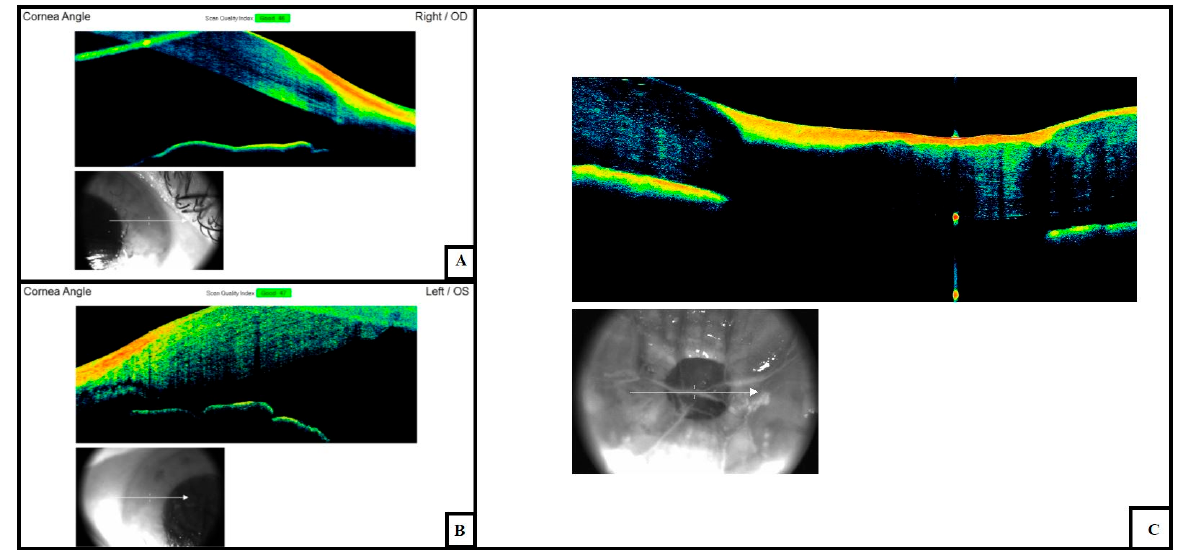
Figure 4. Changes in the anterior chamber amplitude at ( A ) early (6th hour), ( B ) intermediate (24th–36th hour) and ( C ) advanced (72nd hour) postmortem intervals. This phenomenon can be explained by changes in the corneal thickness and variations in the intraocular tone due to the loss of aqueous humor.